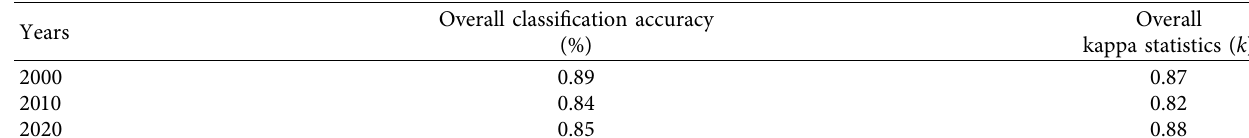
Table 5: Classifcation accuracy and kappa statistics for various LULC maps.